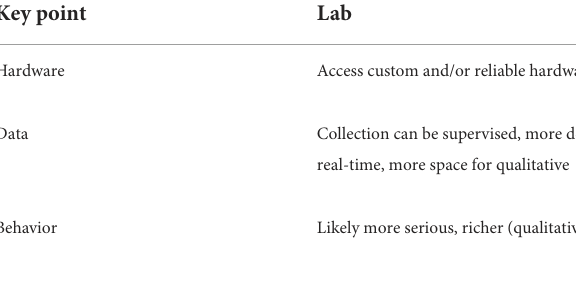
TABLE 3 Data collection key